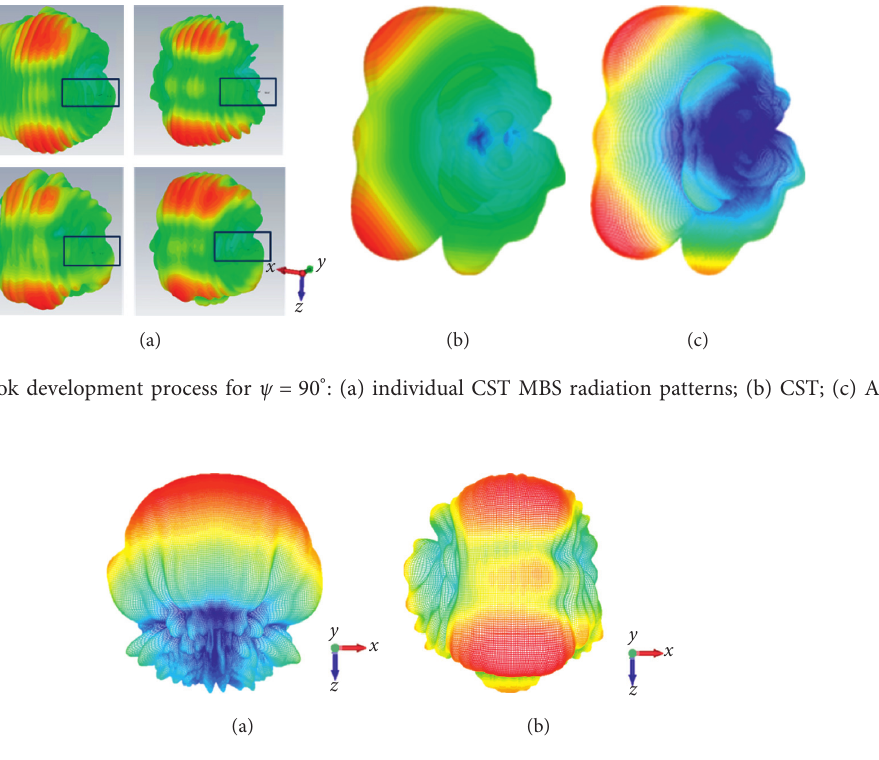
Figure 12: 3D 17-entry codebook envelope representation: (a) PBS; (b) MBS.